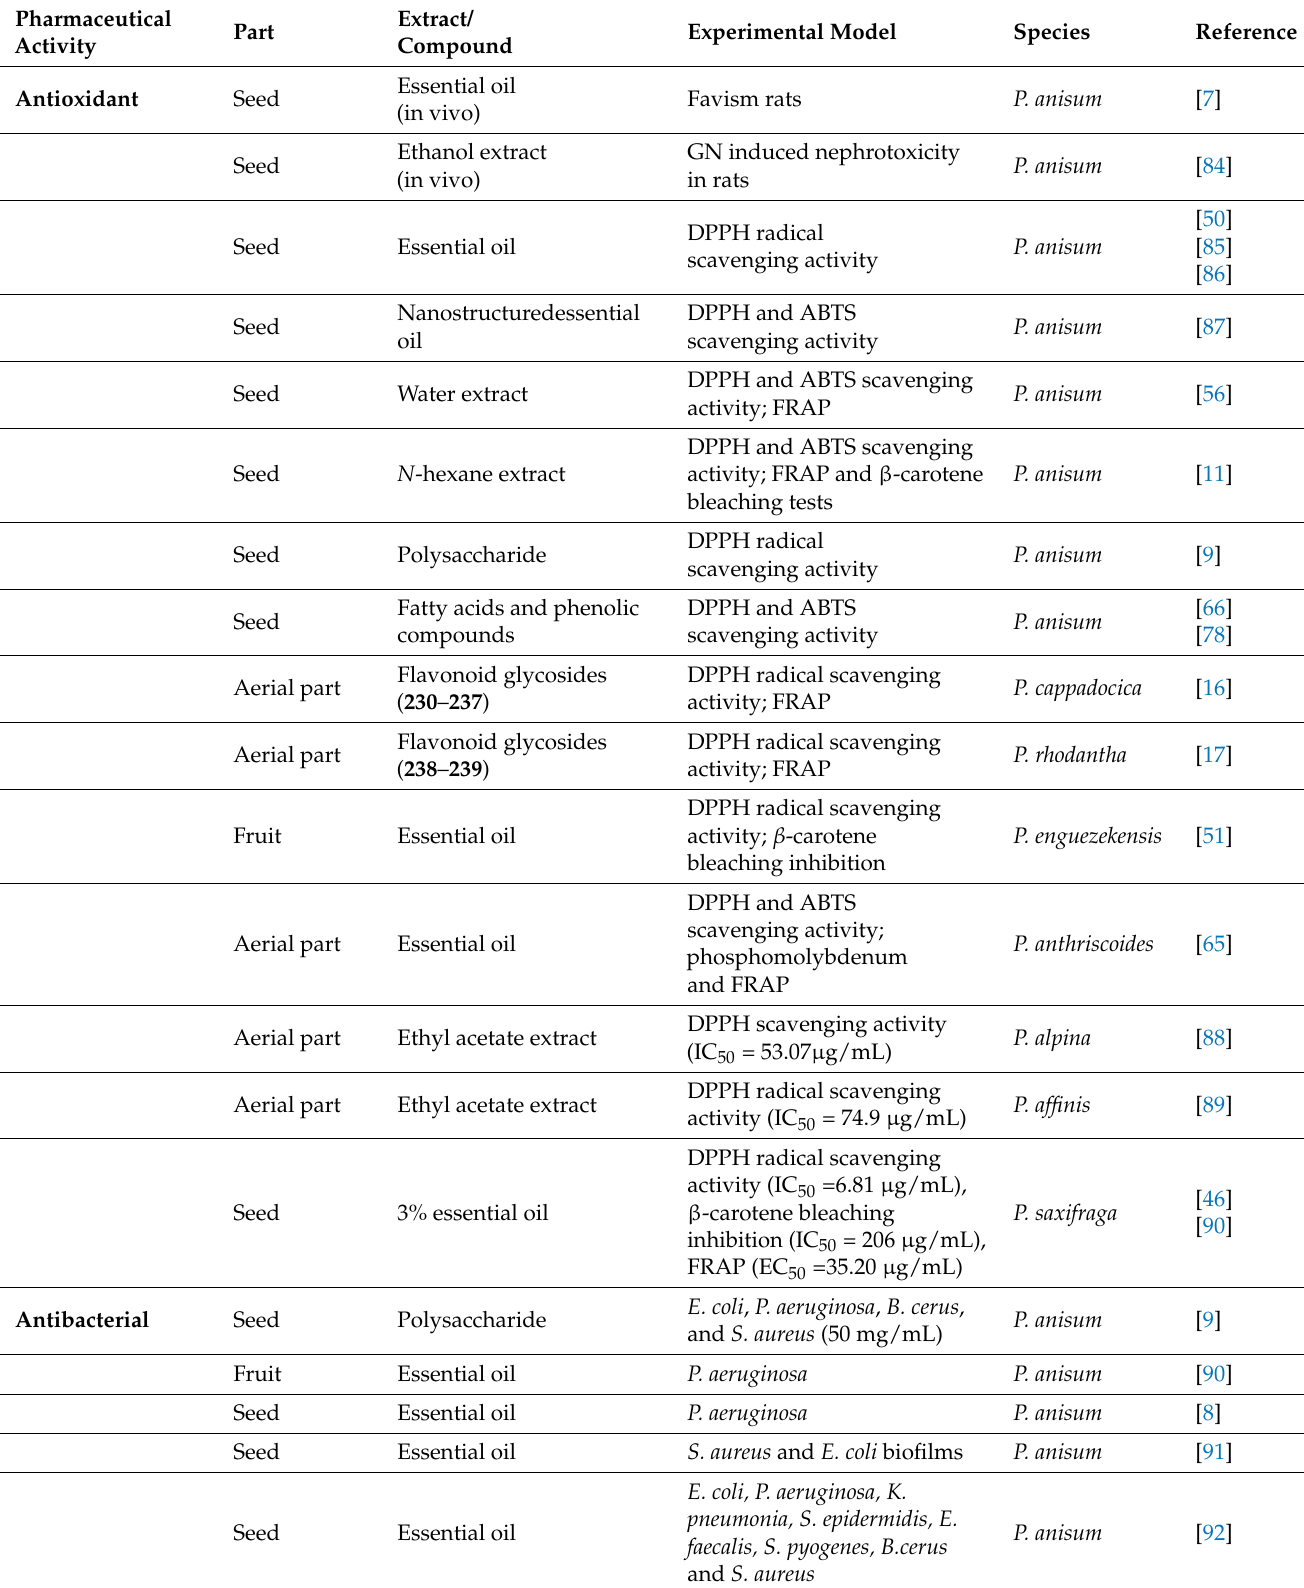
Table 8. The pharmaceutical effects of Pimpinella